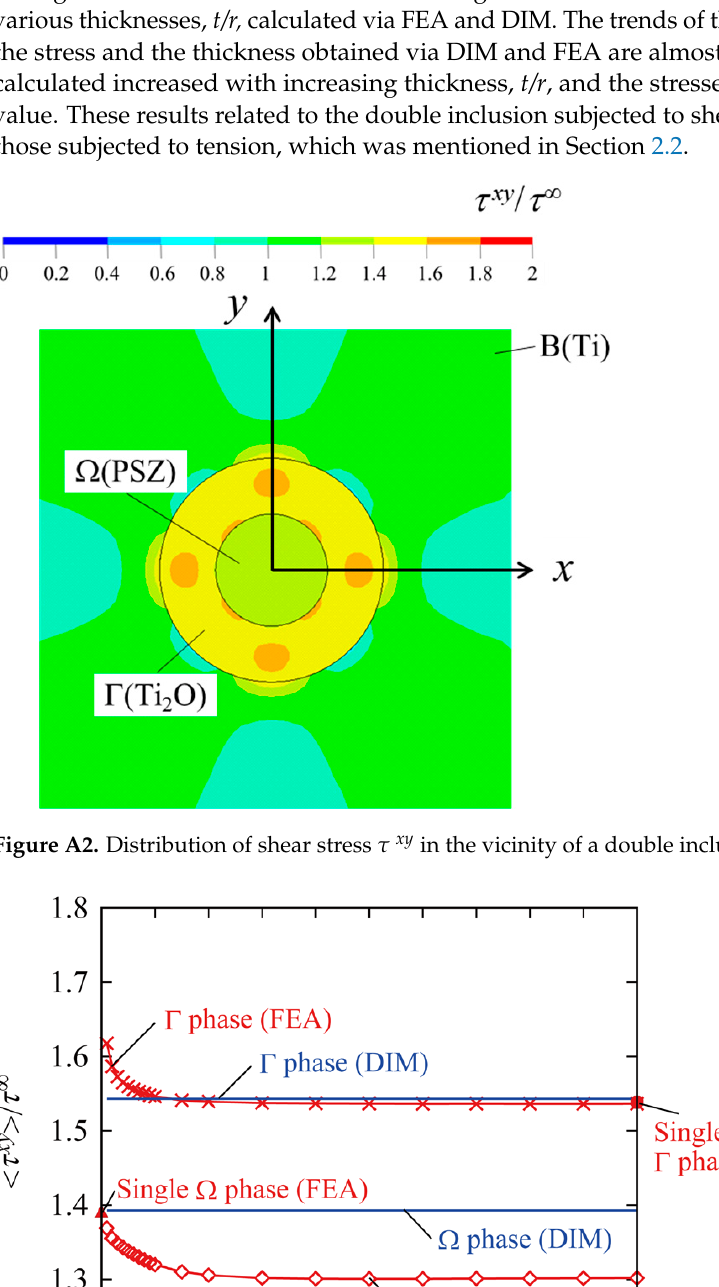
Figure A1. Finite element analysis of double inclusion subjected to shear loading.